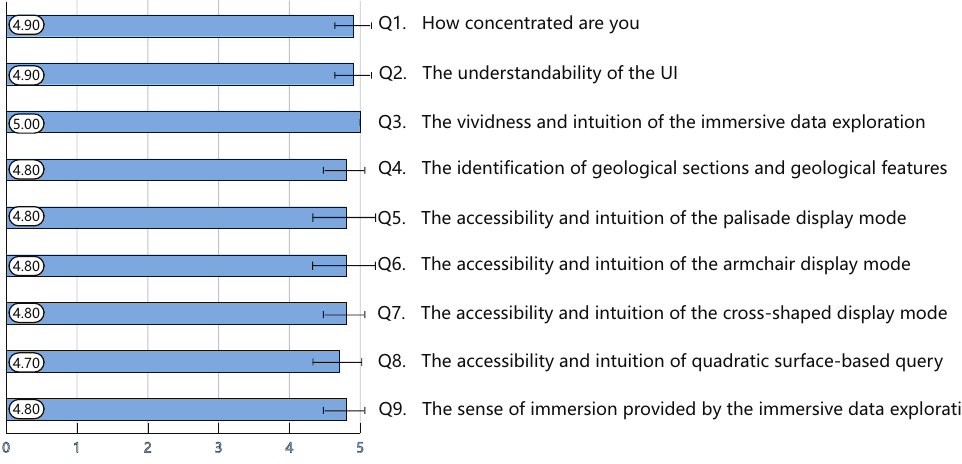
Figure 10. Post-study: questionnaire results. The questionnaire included a series of 5-point Users- scale questions about the usability and the utility of our tool. All of the participants are not the co-authors of the